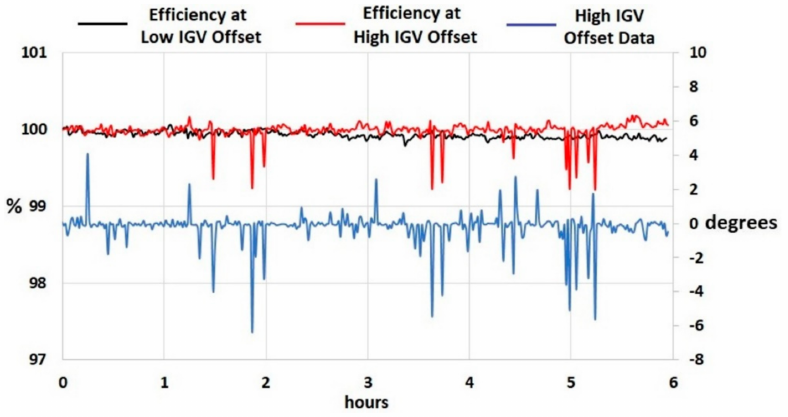
Figure 41. Simulated compressor efficiency at low and high IGV offset conditions.